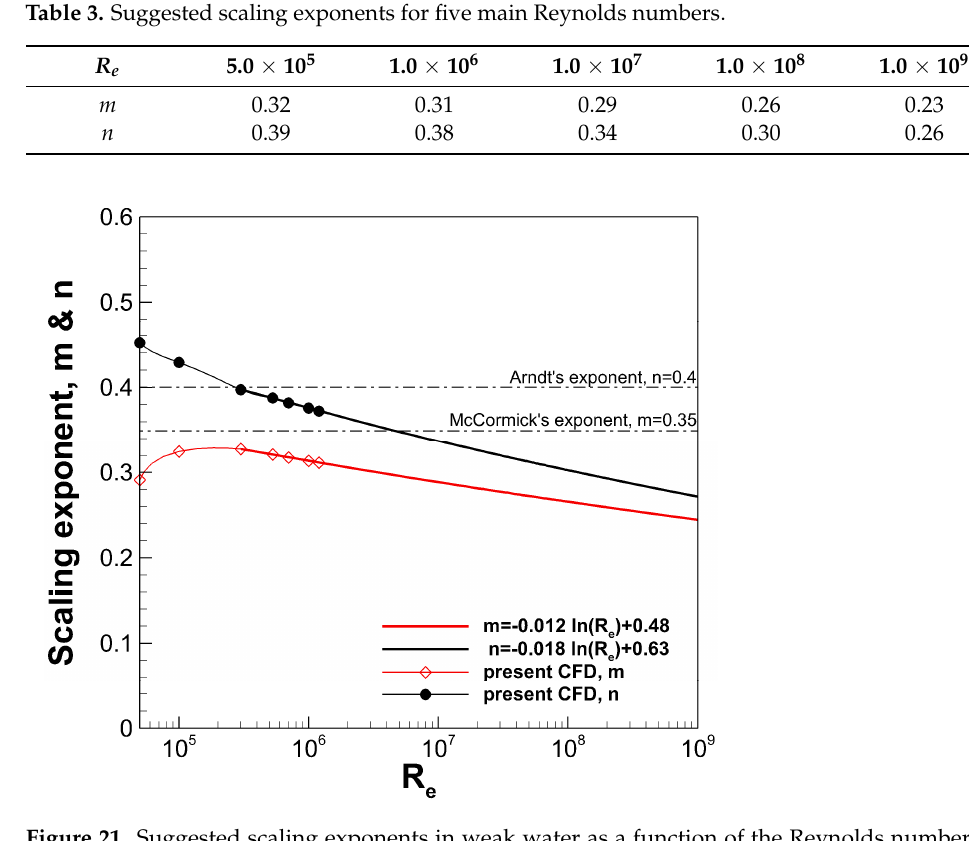
Table 3. Suggested scaling exponents for five main Reynolds numbers.